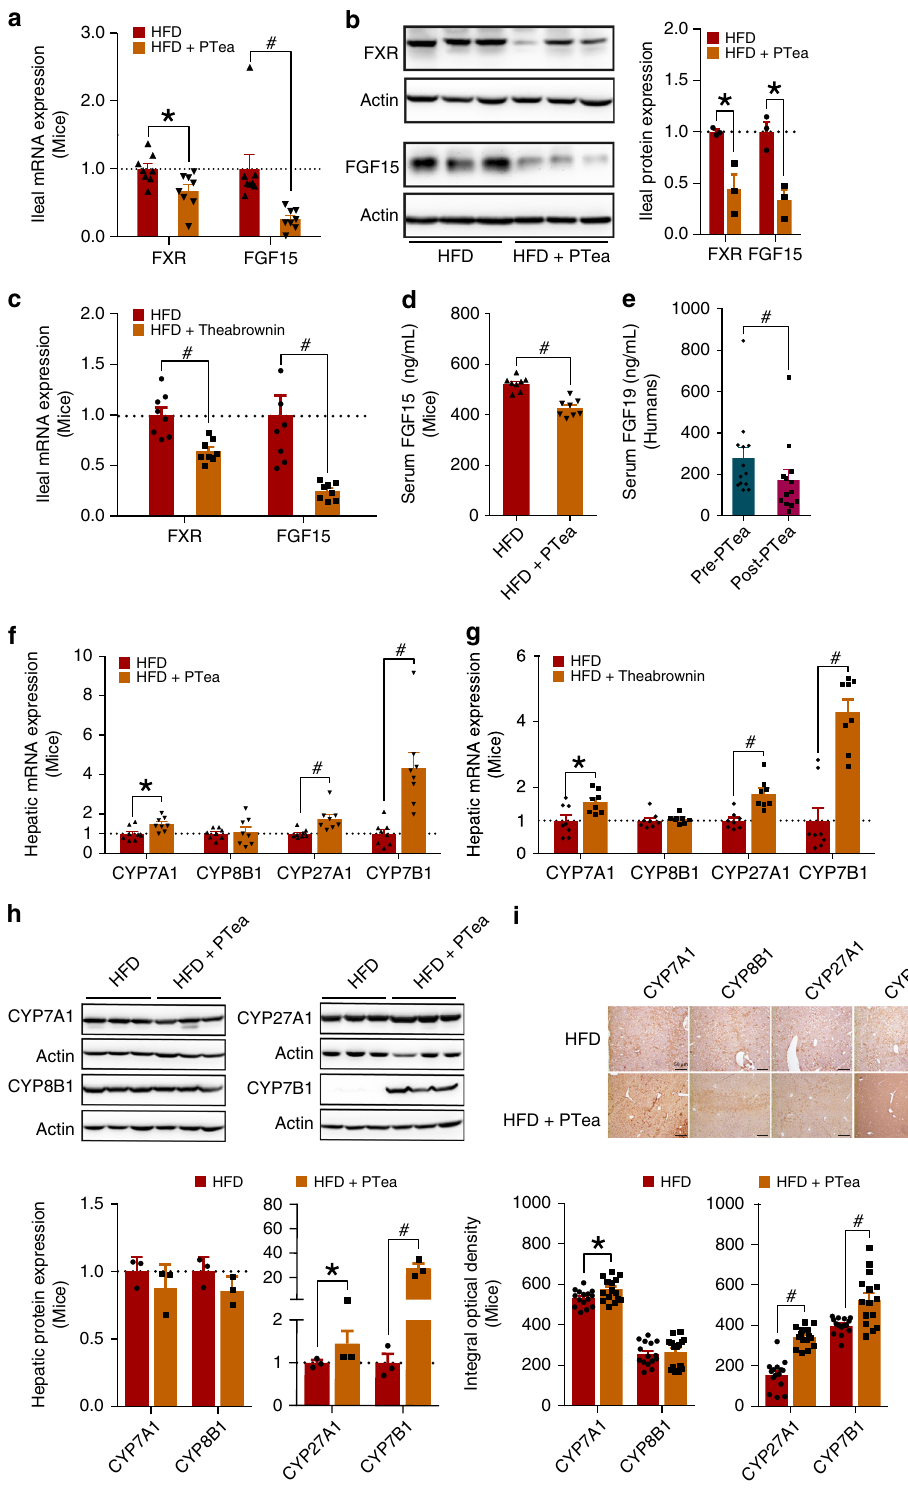
further analyzed using immuno fl uorescence staining. Similar to the mRNA expression results, both TCDCA and TUDCA inhibited FXR and FGF15 protein expression in ileum and ele- vated FXR-SHP expression levels. Moreover, induction of BA synthesis by theabrownin, TCDCA, or TUDCA for 8 weeks resulted in a signi fi cant reduction of hepatic and serum choles- terol levels as well as body weight (Supplementary Fig.